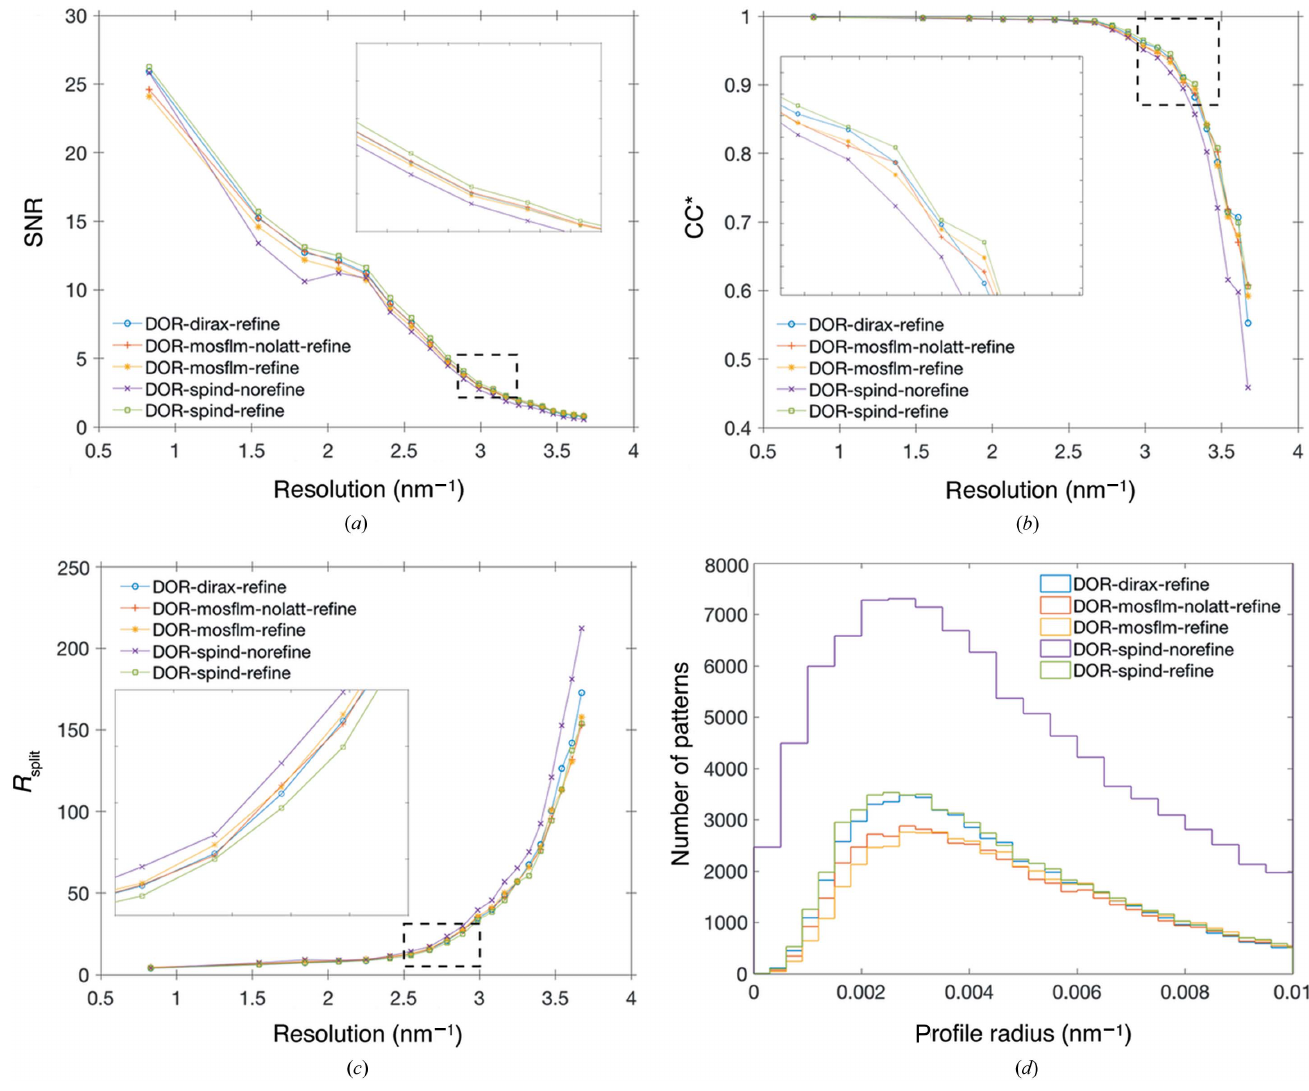
Figure 5 Figures-of-merit as a function of resolution for DOR SFX data. ( a ) SNR, ( b ) CC * , ( c ) R split and ( d ) Bragg reflection profile radii determined by indexamajig . See Fig. S2( a ) for full range of reflection profile radii and Fig. S2( b ) for reflection multiplicity in merged data sets in the Supporting information. The keywords ‘refine’ and ‘norefine’ represent the on and off status of the lattice-refinement option in indexamajig in the indexing process. ‘nolatt’ represents that the reference cell and lattice type were not used as input for indexing (but were used as constraints for the indexing